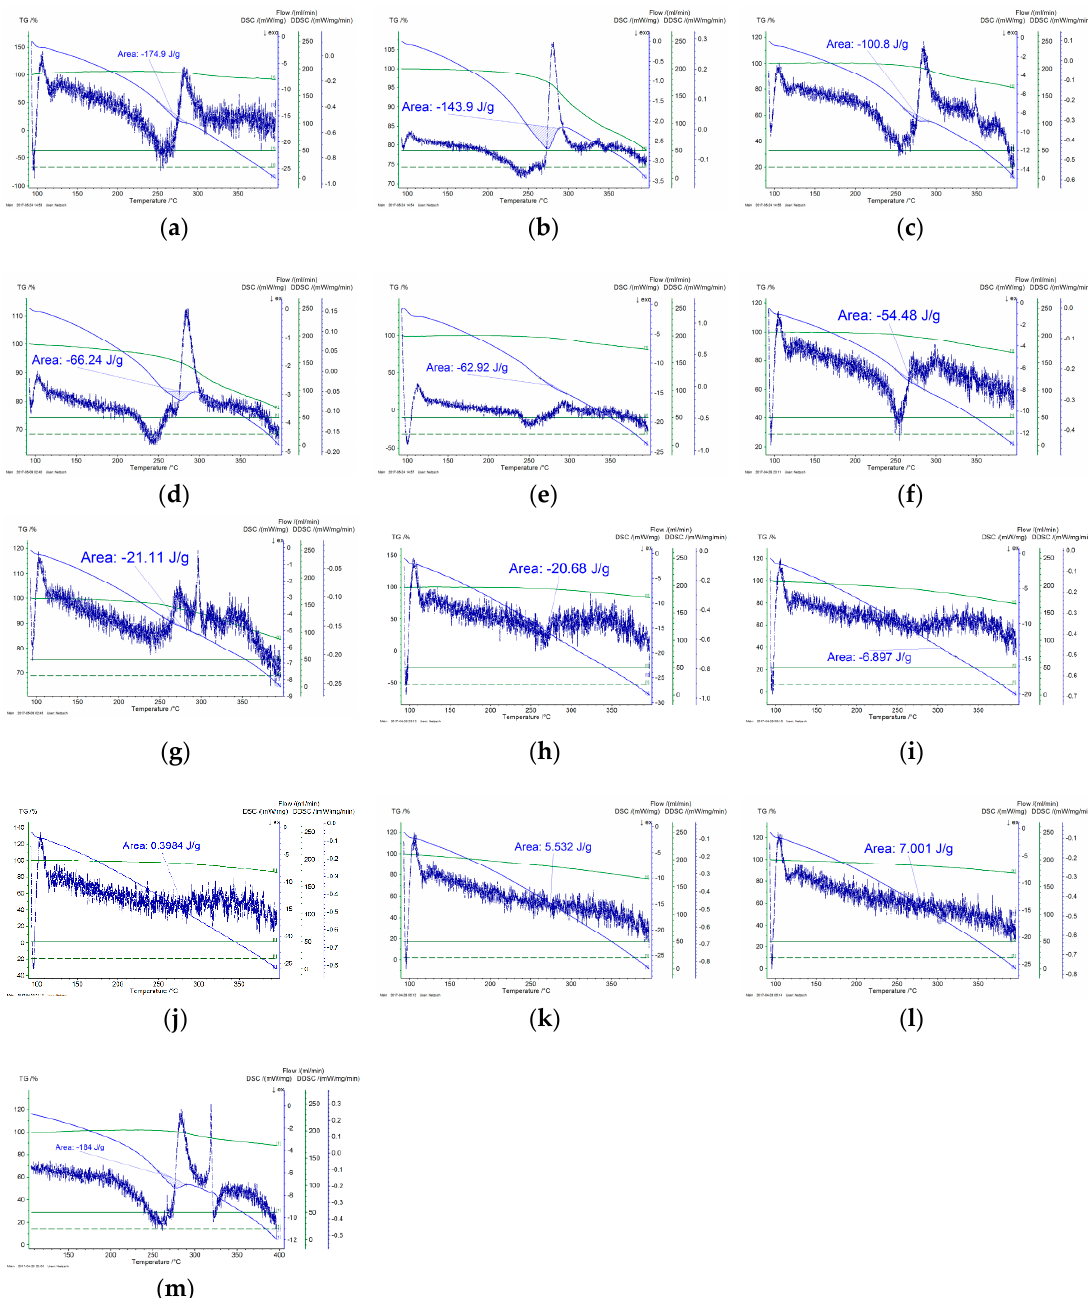
Figure A2. DSC-TGA-DTG thermal analysis of stabilized PAN fibers at ( a ) 160 °C, ( b ) 170 °C, ( c ) 180 °C, ( d ) 190 °C, ( e ) 200 °C, ( f ) 210 °C, ( g ) 220 °C, ( h ) 230 °C, ( i ) 240 °C, ( j ) 250 °C, ( k ) 260 °C, ( l ) 270 °C, and ( m ) untreated, tested in inert N 2 atmosphere.